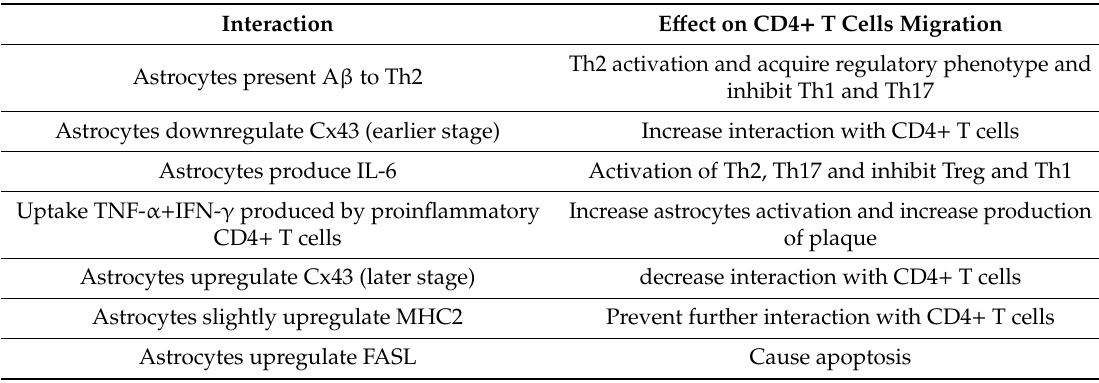
Table 6. Mechanism of action with which Astrocytes increase CD4 + T cells migration in AD. Interaction E ff ect on CD4 + T Cells Migration Th2 activation and acquire regulatory phenotype and Astrocytes present A β to Th2 inhibit Th1 and Th17 Astrocytes downregulate Cx43 (earlier stage) Increase interaction with CD4 + T cells Astrocytes produce IL-6 Activation of Th2, Th17 and inhibit Treg and